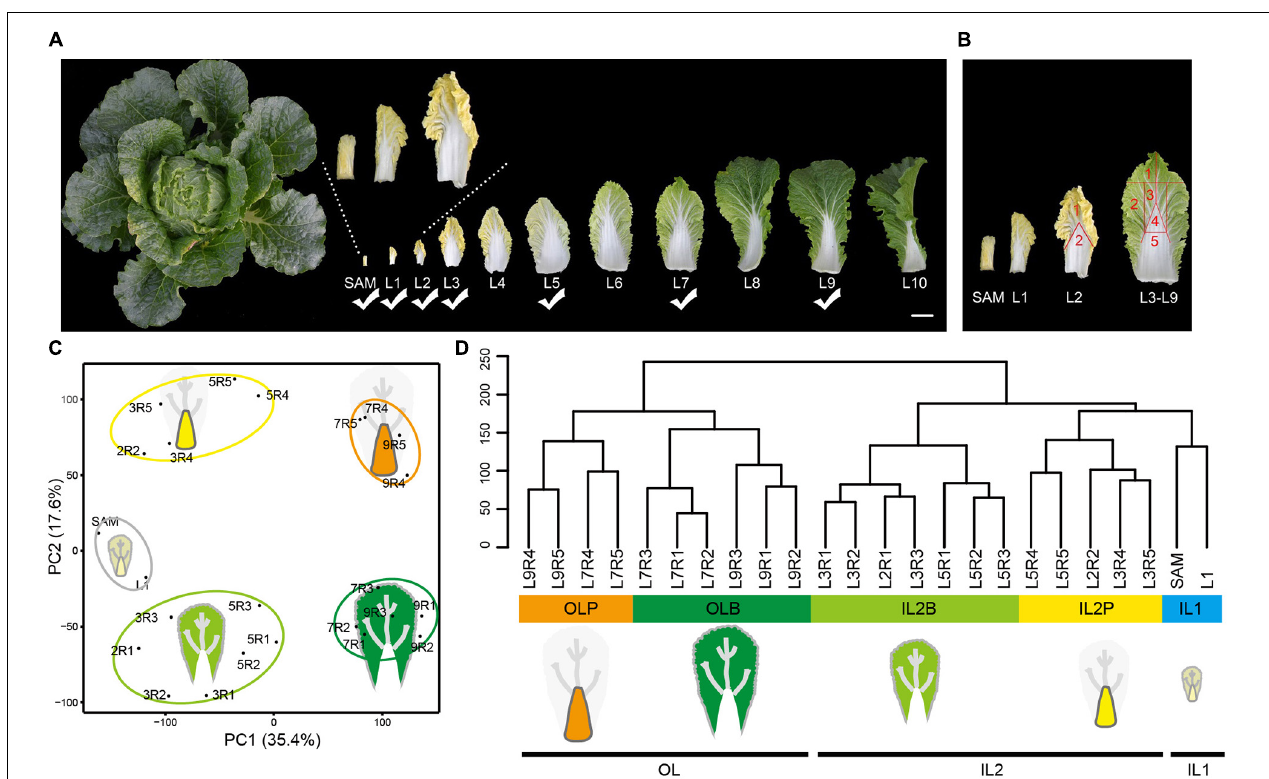
FIGURE 1 | Transcriptome profiling of Chinese cabbage leaves in different leaf layers at the heading stage. (A) Representative pictures of leaves spanning 11 leaf layers. The leaf layers marked with a check mark were used for RNA-seq. Scale bar is 5 cm. (B) L2 was divided into two regions (including leaf blades and petioles) for sampling. L3, L5, L7, and L9 were divided into five regions (named R1, R2, R3, R4, and R5, respectively) for sampling. (C) PCA of the transcriptomes of the 24 different tissues. The first PC (PC1) distinguished leaf positioning from SAM and explained 35.4% of the total sample variation. The second PC (PC2; 17.6% of sample variance) clearly distinguished the petioles from the leaf blades. (D) The cluster dendrogram for total samples. IL1 inner leaves 1; IL2B, blade of inner leaves 2; IL2P, petiole of inner leaves 2; OLB, outer leaf blade; OLP, outer leaf